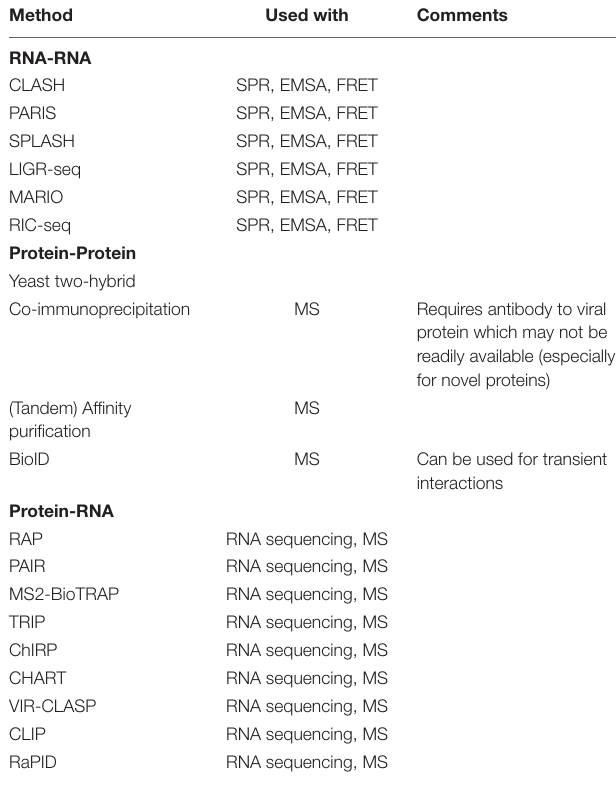
TABLE 1 | Methods to investigate interacting